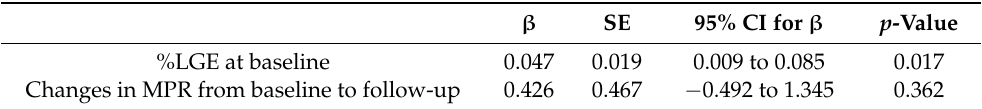
Table 4. Multiple linear regression analysis of the relations between changes in longitudinal strain, transmural extent of late gadolinium enhancement, and changes in myocardial perfusion reserve. β SE 95% CI for β p -Value %LGE at baseline 0.033 0.011 0.012 to 0.054 0.002 Changes in MPR from baseline to follow-up − 1.103 0.257 − 1.608 to − 0.597 <0.001 LGE, late gadolinium enhanced; MPR, myocardial perfusion reserve. Table 5. Multiple linear regression analysis of the relations between changes in circumferential strain, transmural extent of late gadolinium enhancement, and changes in myocardial perfusion reserve. β SE 95% CI for β p -Value %LGE at baseline 0.047 0.019 0.009 to 0.085 0.017 Changes in MPR from baseline to follow-up 0.426 0.467 − 0.492 to 1.345 0.362 LGE, late gadolinium enhanced; MPR, myocardial perfusion